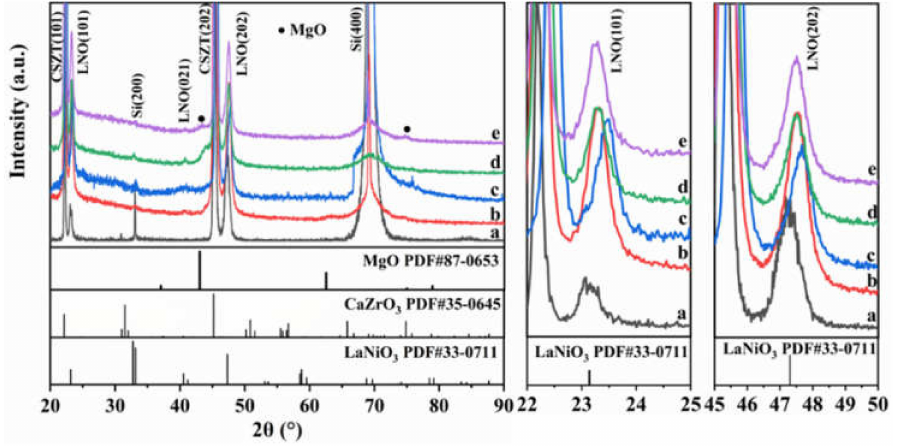
Figure 1. X -ray diffraction pattern of x% Mg 2 TiO 4 -CSZT thin films in the 2 θ range of 20–90 ◦ . ( a ) x = 0; ( b ) x = 2; ( c ) x = 4; ( d ) x = 6; ( e ) x =